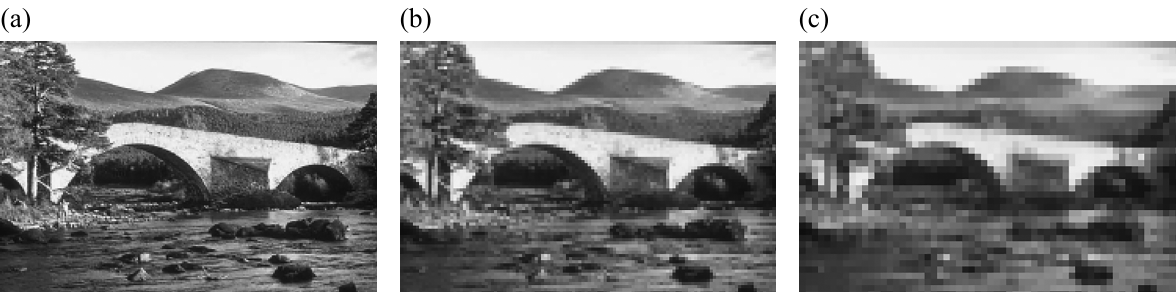
Fig. 8. The example of an image with HD where the Haar wavelet transformation is applied to three levels of